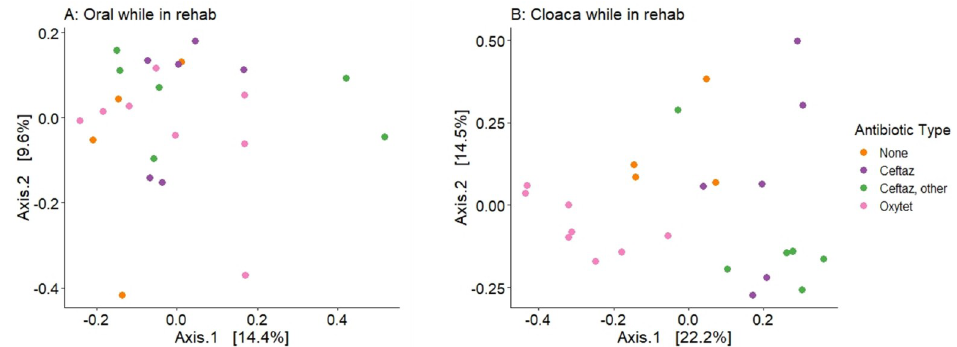
Fig 7. Microbial communities during rehabilitation and antibiotics. Principal coordinate analysis (PCoA) plots of oral (A) and cloacal (B) samples based on Bray-Curtis distance during rehabilitation (TP2). Colors specify the type of antibiotic the turtle was on during